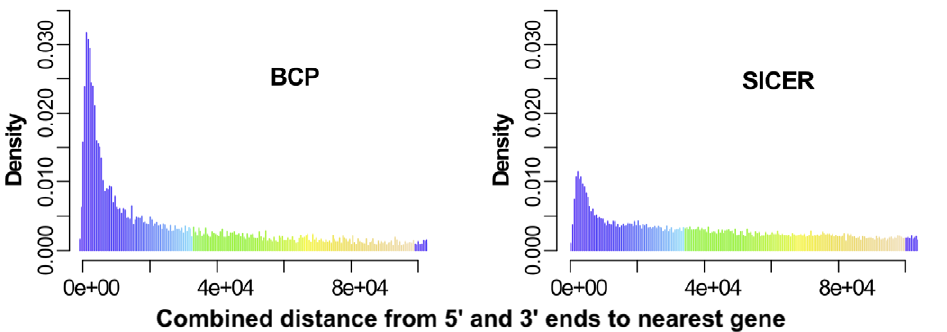
Figure 2. The distance from H3K36me3 island boundaries to nearest gene boundary was used as a measure of accuracy. H3K36me3 islands have been shown to correspond to actively transcribed gene bodies so we expected the boundaries of island and genes to coincide. The sum of the distances from both upstream and downstream island boundaries to the nearest gene boundaries were used as a per island error and illustrated in the histogram for BCP (left) and SICER